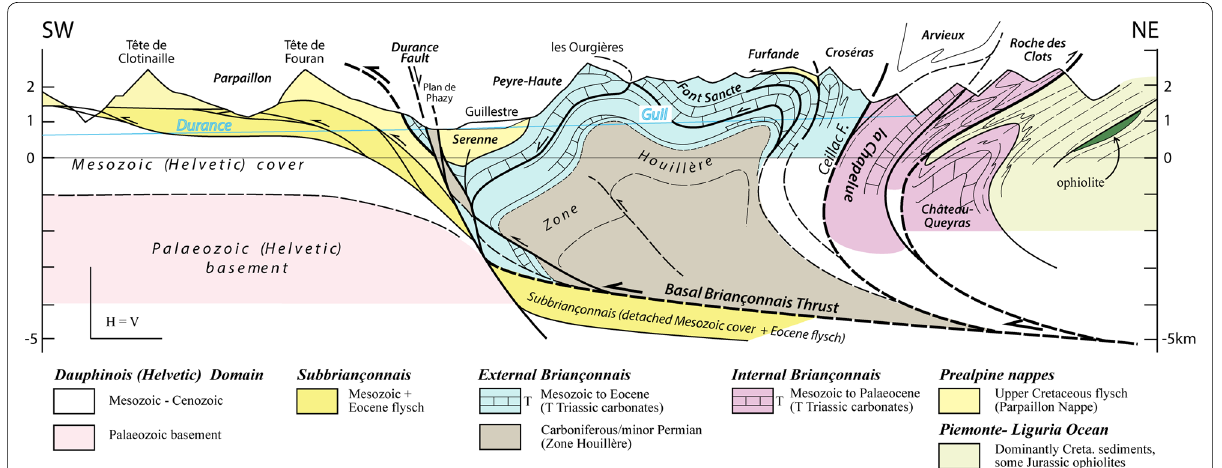
Fig. 2 Simplified cross-section of the Briançonnais Domain along the Guil valley. The colour code is the same as in Fig. 1. The upper part (i.e. above sea-level) of the section closely follows Debelmas et al. (1966) and Kerckhove et al. (2005). The lower part (i.e. below sea-level) is intended to display a potential geometry of the nappe stack at depth. The normal fault displacement along the Durance Fault, which offsets the basal Briançonnais Thrust, is drawn according to Debelmas (1955) and Tricart et al. (1996), and may have been accompanied by a strike-slip displacement. The pre-Triassic basement, made of Carboniferous sediments and Permian volcanics, is only poorly exposed west of the Durance Fault, but preserved north of the section considered here. Permian sediments, formerly considered as a granite (Kerckhove and Piboule 1999; Kerckhove et al. 2005), occur in a narrow fault-bounded slice along the Durance Fault (Plan-de-Phazy). The largest outcrop of Permian andesites studied here is located in the Lower Unit of the External Briançonnais (Fig. 3). Note that backfolding and backthrusting inverted the original nappe stack, bringing the units of the Internal Briançonnais over calcschists and minor ophiolites derived from the Piemonte-Liguria